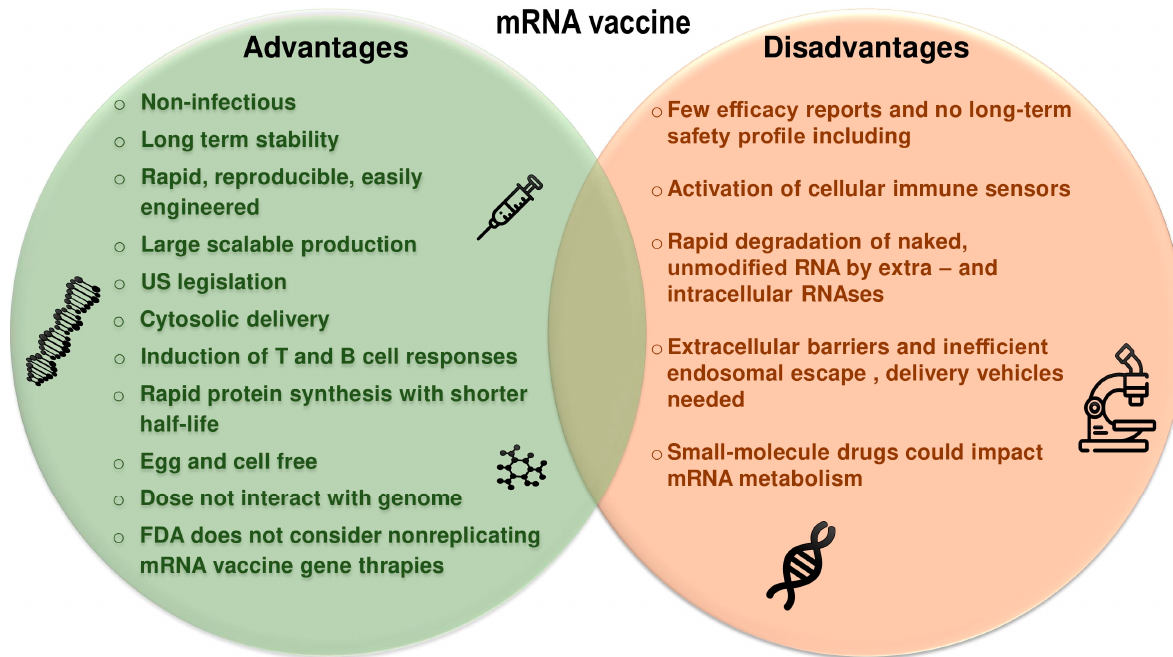
Figure 2. Comparison between the advantages and disadvantages of mRNA vaccines.